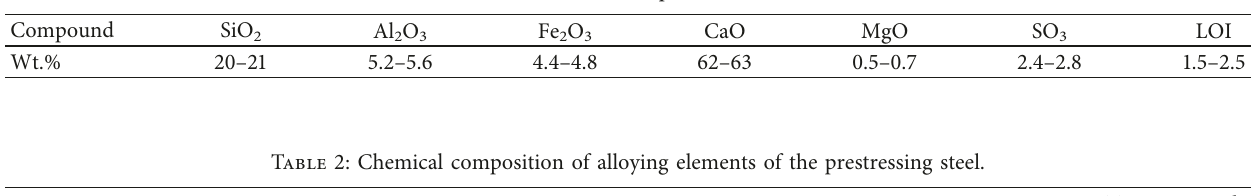
Table 1: Chemical composition of OPC.